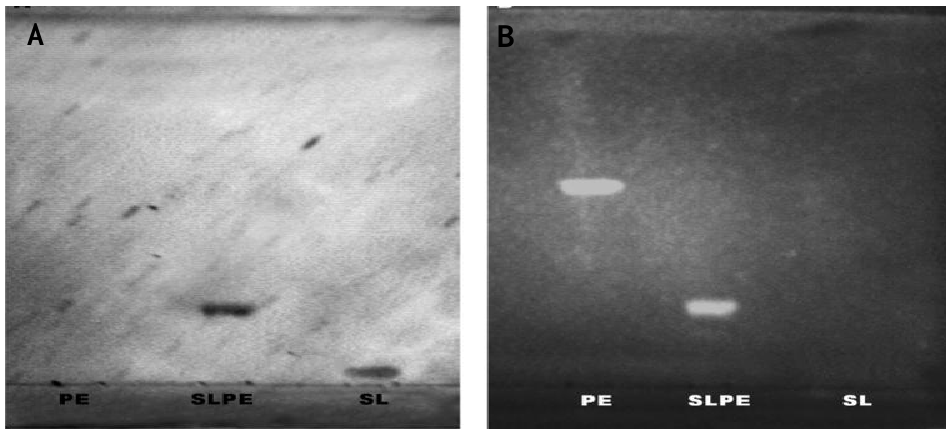
Figure 3. Evaluation of the purity of SLPE. The purity of SLPE following synthesis and Section. ( A ) TLC chromatogram stained by resorcinol spray to detect sialic acid-containing bands. The chromatographic mobility of SLPE is shown along with standard PE and SL. ( B ) a parallel chromatogram as described in A was run, stained with primulin, and photographed under UV light to detect lipid-containing